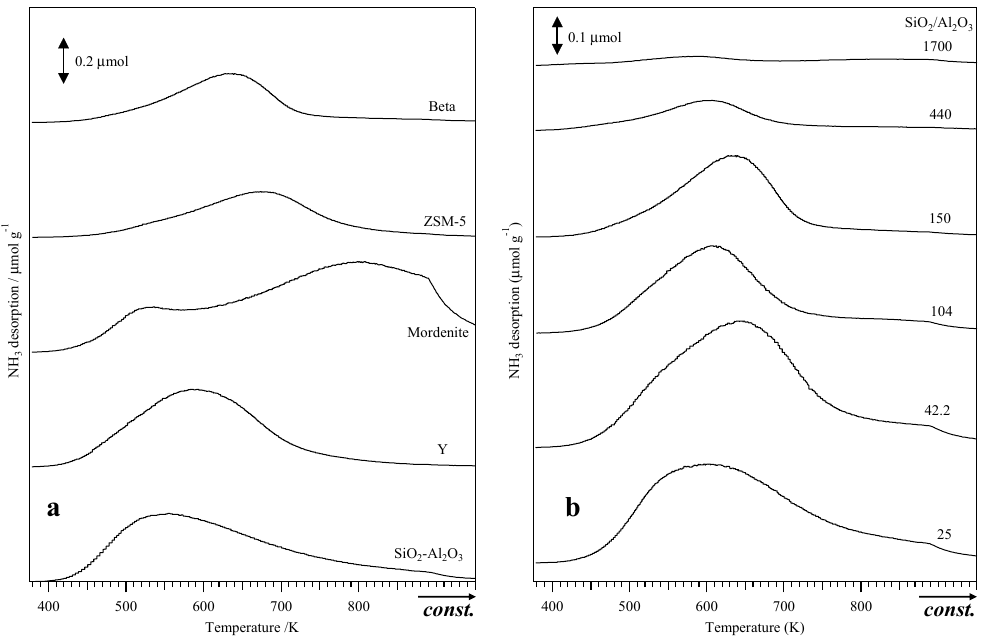
Figure 2. NH 3 -temperature programed desorption (NH 3 -TPD) of ( a ) four types of reference zeolites and normal SiO 2 -Al 2 O 3 and ( b ) zeolite betas composed with various SiO 2 /Al 2 O 3 ratios.